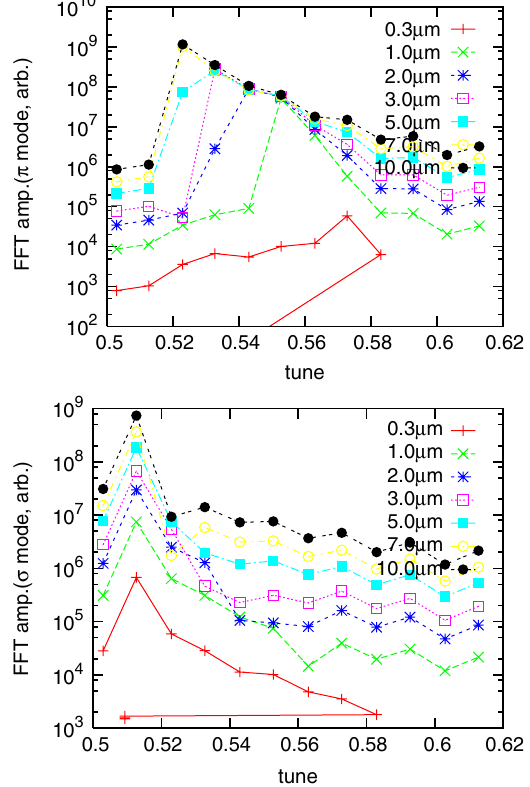
FIG. 7. Response of (cid:4) and (cid:5) mode amplitudes for the har- monic excitation frequency and